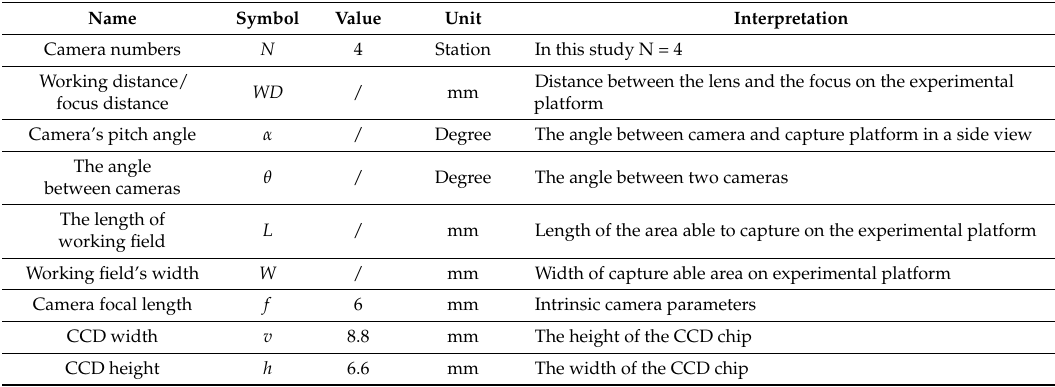
Table A1. Parameter definition